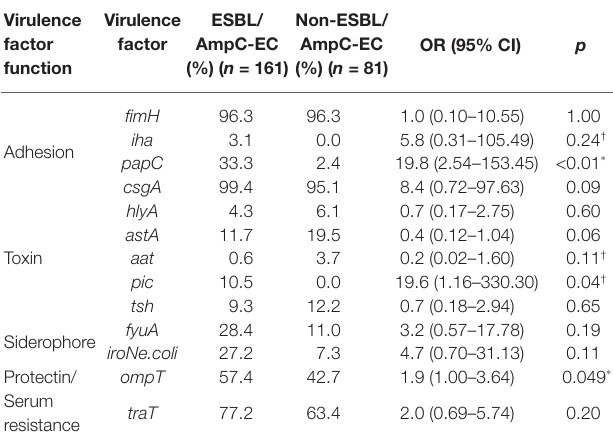
TABLE 1 | Comparison of the carriage of extra-intestinal pathogenic E. coli associated virulence factors (ExPEC VFs) between extended spectrum β -lactamase (ESBL)- or AmpC β -lactamase (AmpC)-producing E. coli (ESBL/ AmpC-EC) and non-ESBL/AmpC-EC